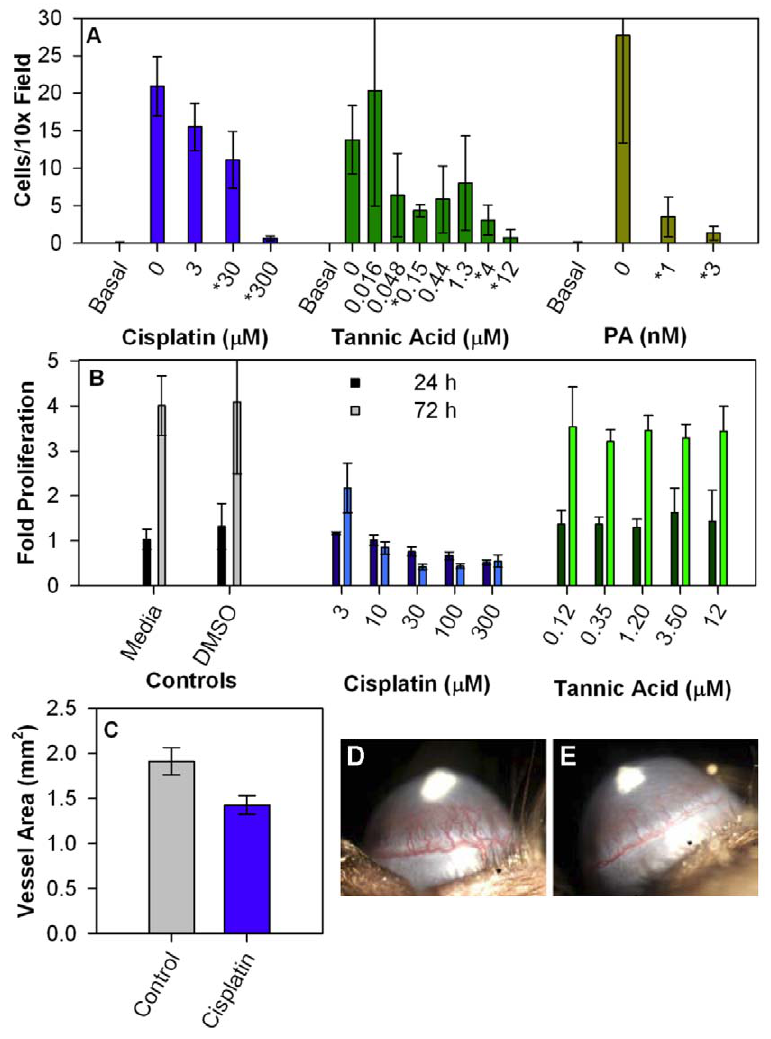
Figure 6. Invitroandinvivo effects of identified PA-CMG2 inhibitors. A ) The effect of various concentrations of cisplatin or tannic acid on endothelial cell migration toward serum-containing medium; effects of PA administration are shown for comparison. Error bars represent standard deviation of the mean (SD; n=12, 4 10X fields from 3 membranes). Statistically significant differences between inhibitor-containing and inhibitor-free conditions (as determined by the Holm–Bonferroni method) are shown by asterisks (*) preceding the concentration on the horizontal axis. Each of these experiments was repeated at least twice with concordant results. B ) The effect of various concentrations of cisplatin and tannic acid on cell survival and proliferation. Proliferation assays were performed for 24 (dark bars) and 72 hours (light bars) in the indicated concentration of cisplatin and tannic acid and cell numbers assessed using Cyquant and normalized to controls fixed in ethanol at time 0. At 24 hours, the highest concentration of each molecule resulted in statistically significant decreases (as determined by t-test); however following Bonferroni correction, these differences were not significant. At 72 hours all cisplatin doses resulted in statistically significant decreases in cell number (as determined by the Holm–Bonferroni method). Error bars represent SD, n=3 wells. For DMSO, 7 concentrations from 0.001% to 1% were assessed and no significant difference was observed among conditions. Therefore these data were pooled and thus for this sample n=21 wells. No significant difference between DMSO-containing and media-only samples was observed (t-test). C ) Effect of treatment with 4 mg/kg/day cisplatin on vessel area in the corneal micropocket assay. Control mice were treated with vehicle alone. Error bars represent SEM (n=10 eyes). The observed difference is statistically significant (p , 0.03 by t-test). No animal weight loss with cisplatin administration was observed. D ) Representative image of control eye vessel area. E ) Representative image of cisplatin treated mouse eye vessel area. doi:10.1371/journal.pone.0039911.g006 shown in Figures 7C and D, addition of aliquots of the tannic acid IC 50 of tannic acid on the PA-CMG2 interaction. As shown in Figure 5B, the tannic acid IC 50 curve was complex, suggesting solution to CMG2 result in clear changes in SPR behavior relative multiple binding modes or the presence of impurities with a range to CMG2, versus control sensor surface. These data were not of binding affinities. Due to the complex binding isotherm, we collected under conditions that allowed quantitative determination could not determine an IC 50 . However, these binding data of binding affinity; however, the data indicate significant indicate that there are concentrations of tannic acid that clearly interaction of CMG2 with tannic acid or other solution inhibit PA-CMG2 interaction. Hence, isolation of tannic acid in components at a total concentration of 1 m M, suggesting the high throughput screen was not a false positive. Binding of the dissociation constants similar to or lower than this value. tannic acid solution to CMG2 was corroborated by SPR. As